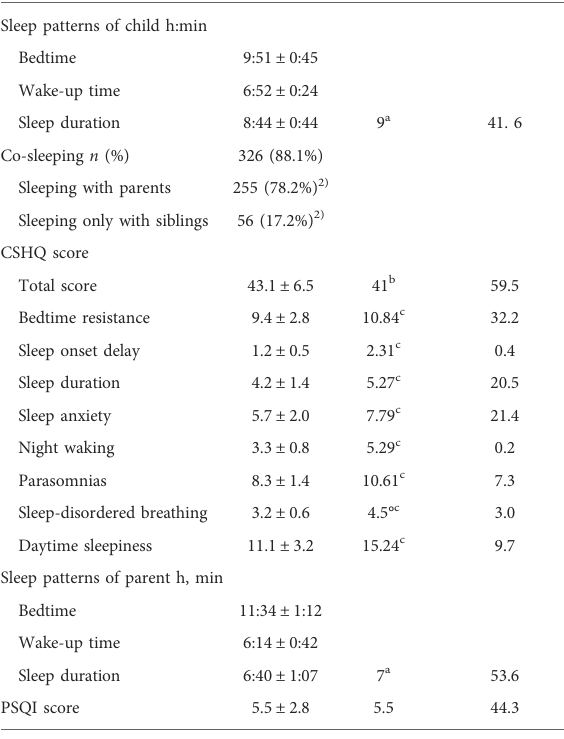
TABLE 4 Characteristics of sleep patterns and disturbances in children and their parents ( n =370).